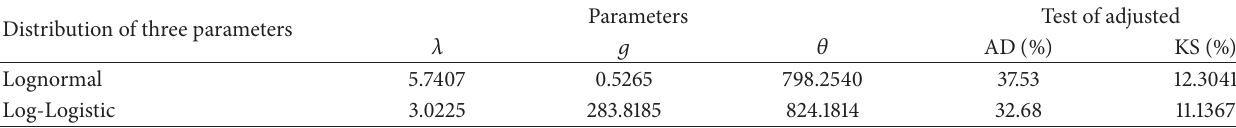
Table 3: Estimates for adjusting the LS ( Λ ) .